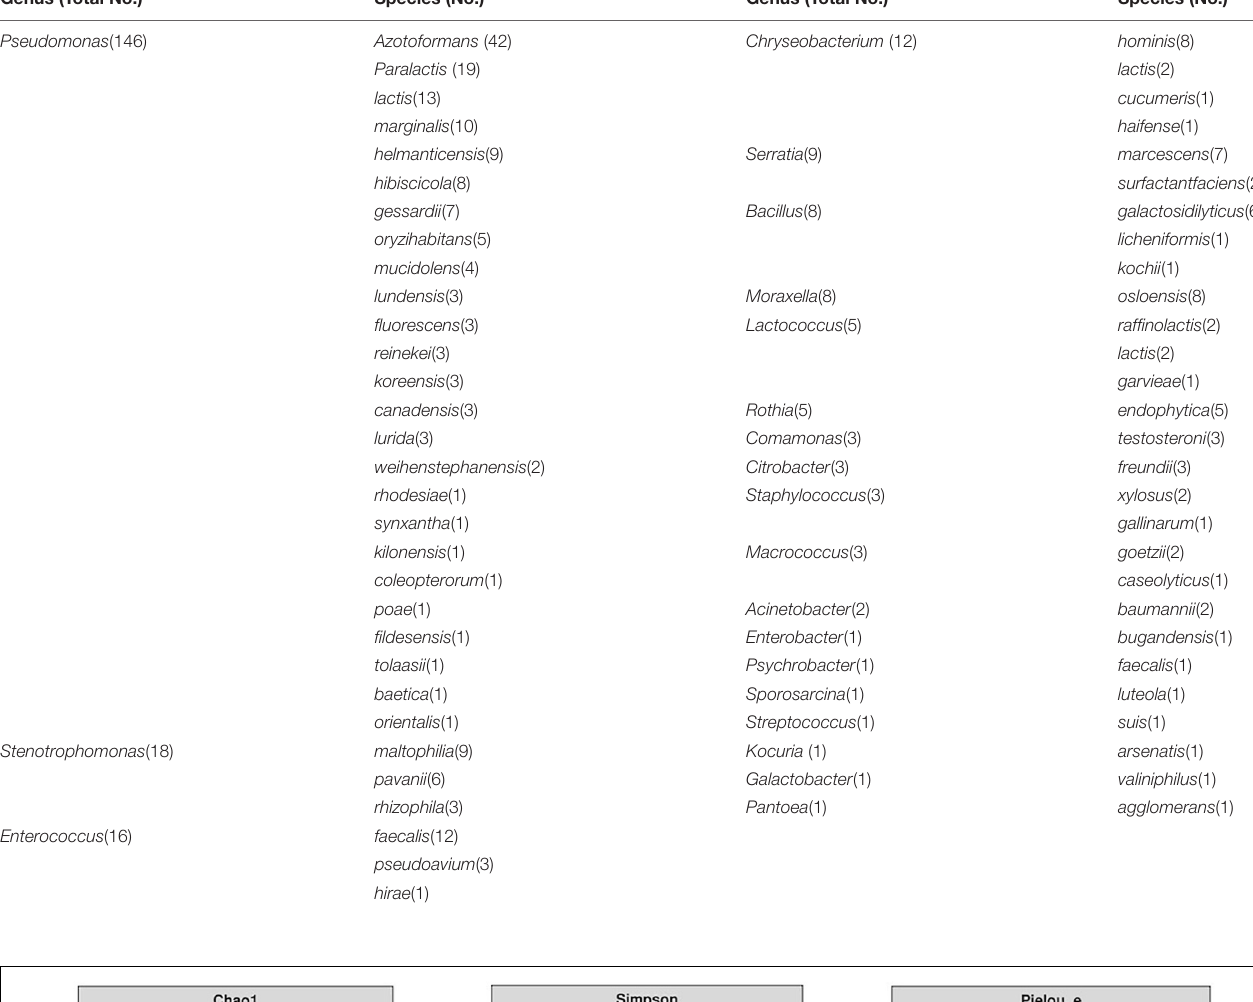
TABLE 2 | Identification and distribution of psychrotrophic bacteria isolated from raw milk samples collected from different regions in China. Genus (Total No.)